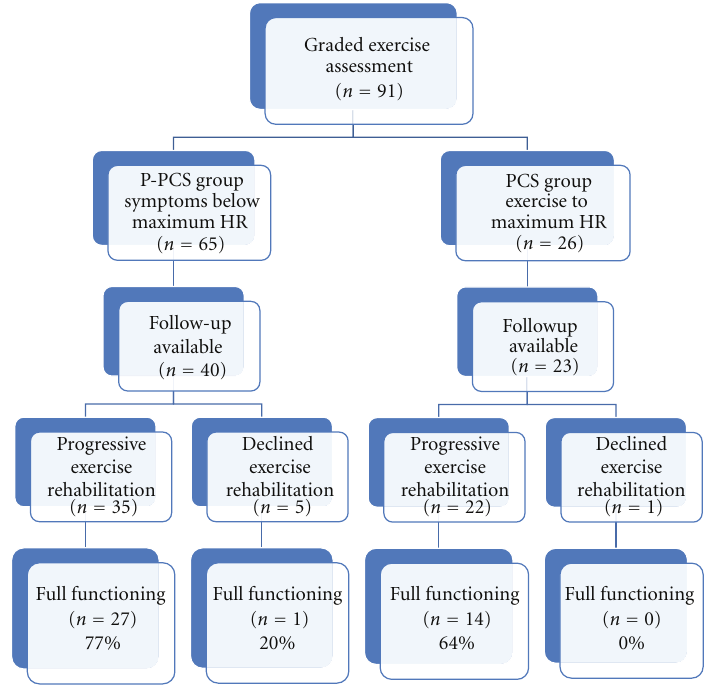
Figure 1: Graded exercise assessment and progressive exercise treatment for P-PCS and PCS groups.